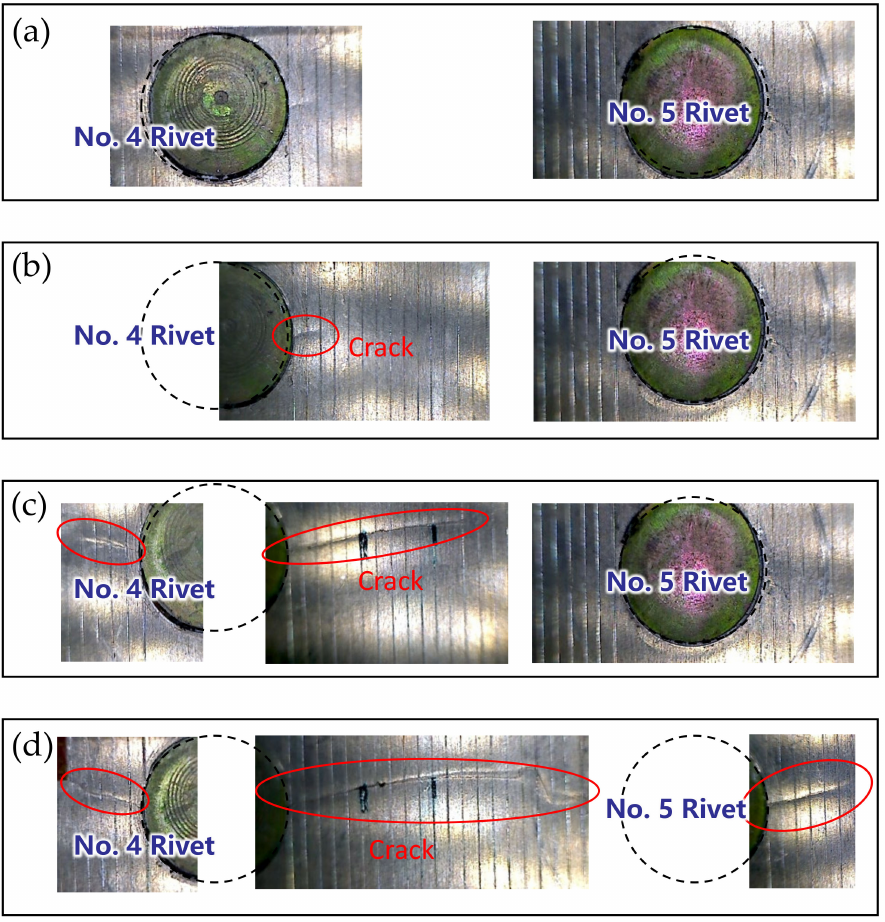
Figure 15. Fatigue cracks of specimen D6 at different stages: ( a ) Total crack length of 0 mm; ( b ) Total